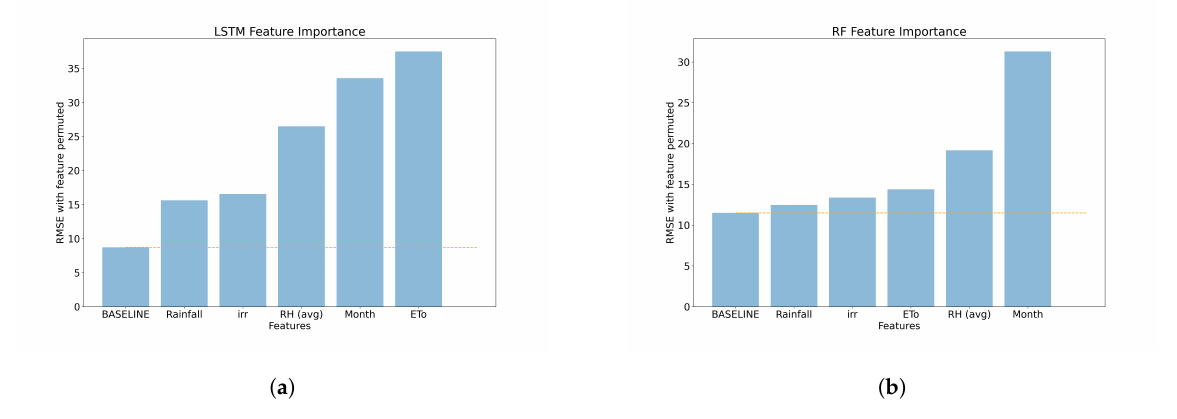
Figure 12. ( a ) shows the importance of the input features for predicting the FTSW with the BiLSTM model, and ( b ) shows the importance of the input features for predicting the FTSW with the RF model. The shift of a feature causing the most changes in the RMSE shows the importance of the